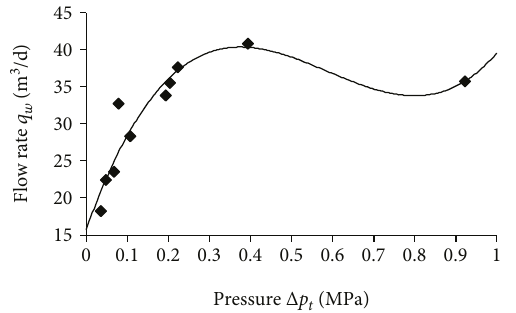
Figure 7: E ff ect of CBM and water column pressure on water production in two-phase producing wellbores.